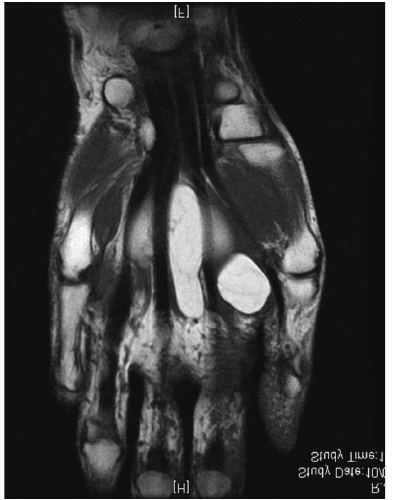
Figure 3: MRI frontal view showing lipoma among flexors tendons and extending to the carpal tunnel.